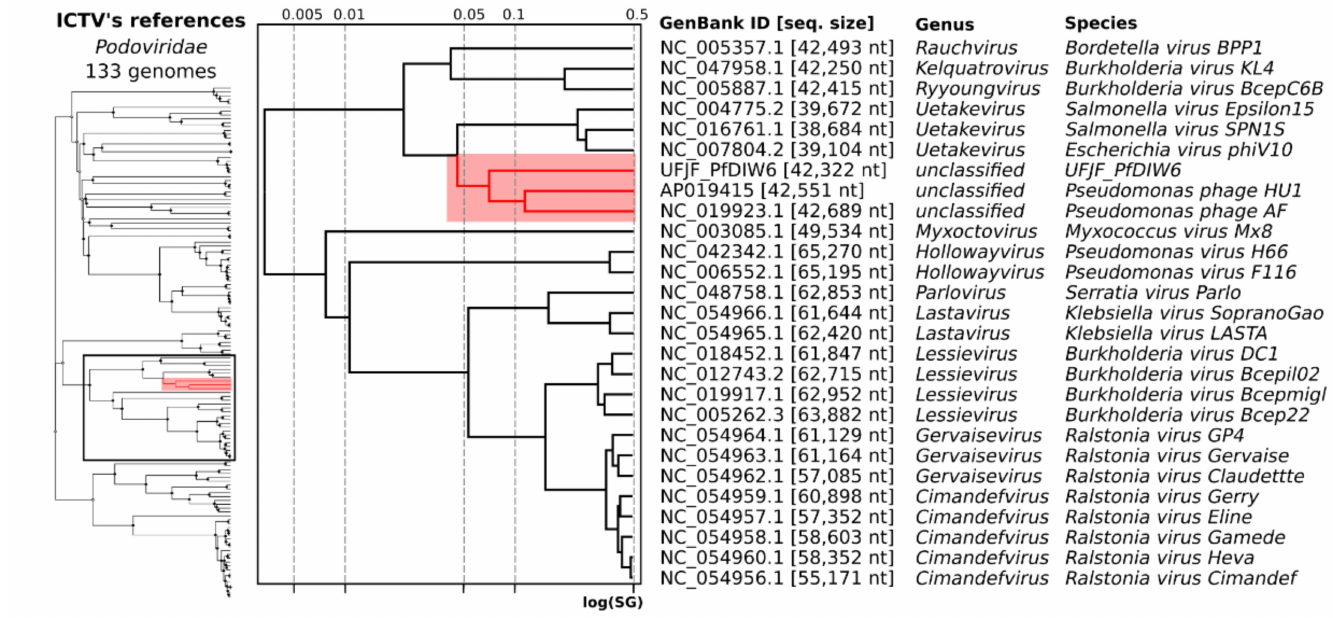
Figure 3. Viral proteomic tree of reference genomes for Podoviridae family. The proteomic tree was obtained from UFJF_PfDIW6 and 130 reference genomes for the genus of Podoviridae phages. The genomes were aligned all-against-all using ViPTree, and the genomic similarity scores (SG) were computed. The cluster, including UFJF_PfDIW6, is highlighted in red. The genomes of Podoviridae phages were also clustered by VIRIDIC using the genomic similarity threshold of 70% for genus assignment (Genus’ cluster) and 95% for species assignment (Species’